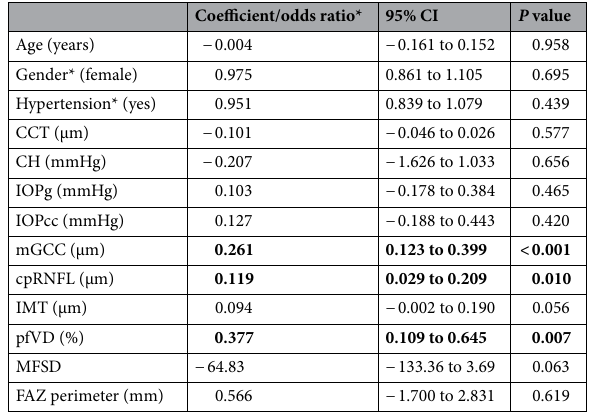
Table 2. Results of univariable regression analyses examine the relationship between MD and other variables. Values with a P -value < 0.05 are highlighted in bold.